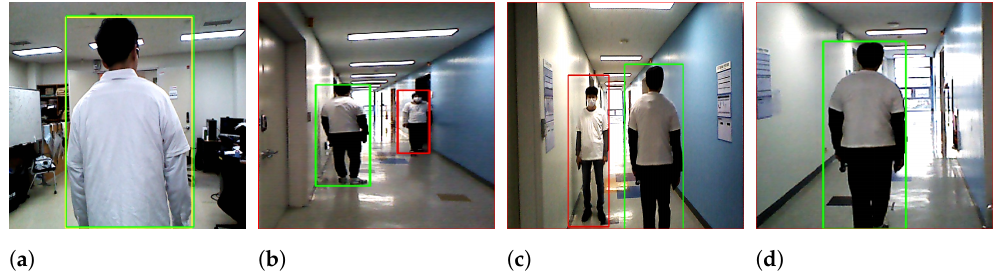
Figure 16. Snapshots of the experiments for target identification under a different lighting environ-